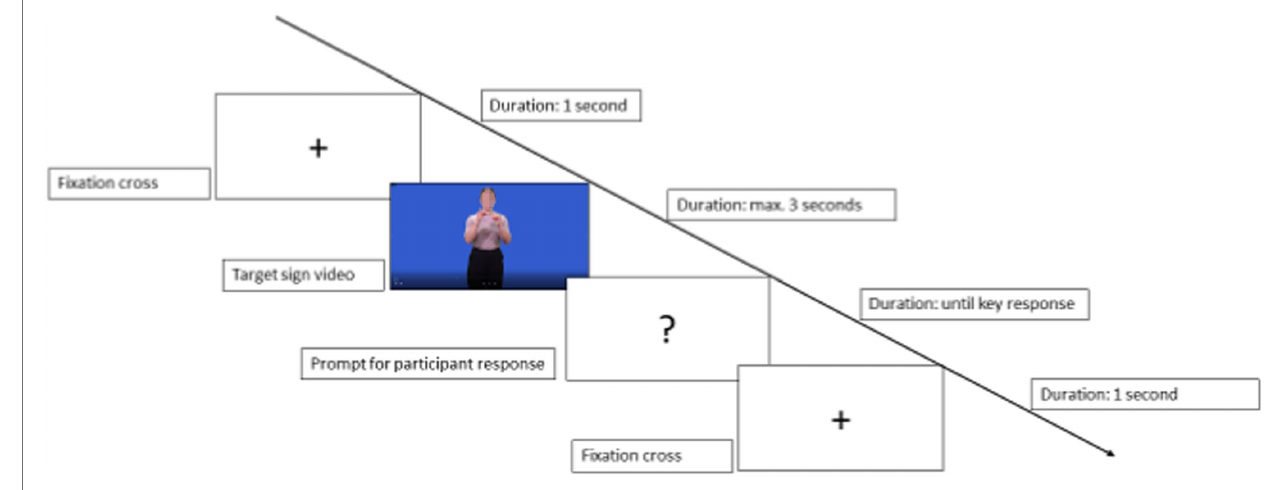
FIGURE 1 | Structure of a trial in the sign recognition